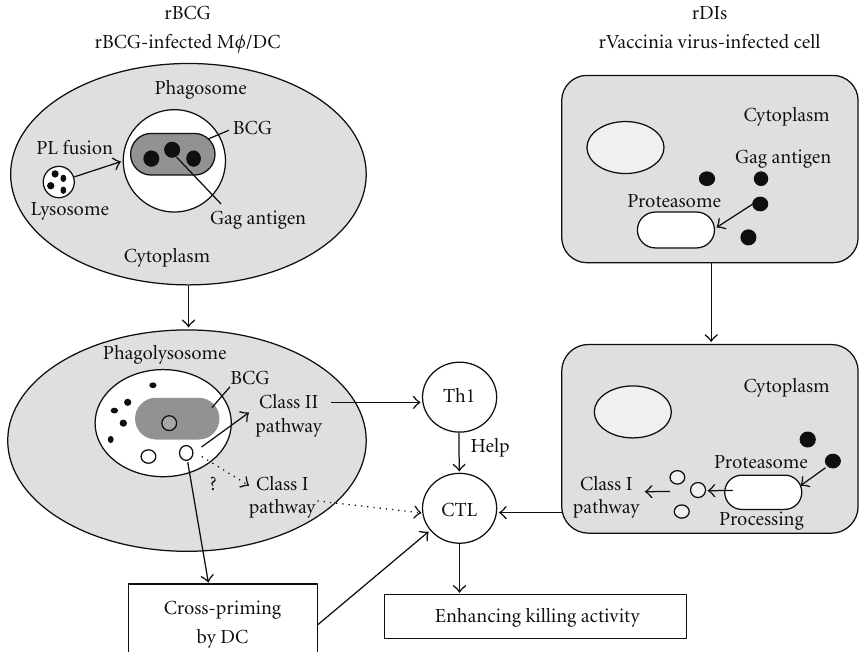
Figure 2: A possible mechanism of e ff ective Gag-specific cell-mediated immunity induction with the rBCG/rDIs prime-boost vaccine. Abbreviations: DC, dendritic cell; M φ , macrophage; PL, phagosome-lysozome; Th1, type 1 helper T cell; CTL, cytotoxic T